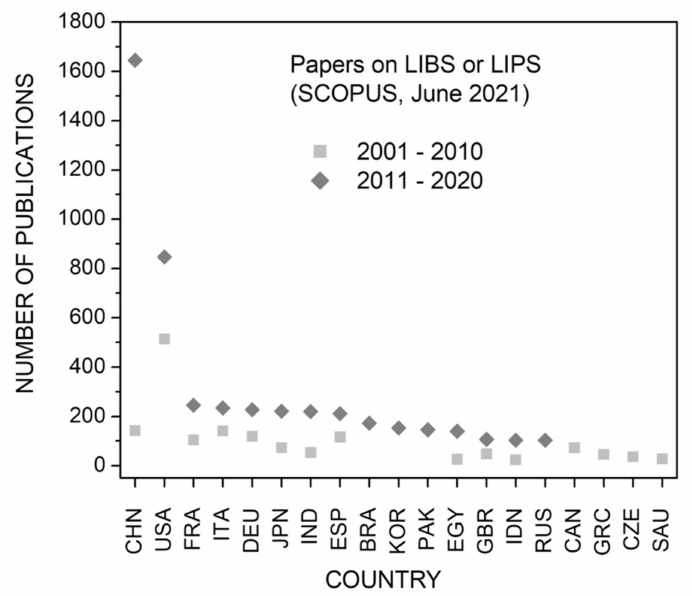
Figure A2. Fifteen top countries, i.e., most frequent country affiliations, regarding scientific papers on LIBS or LIPS published in years 2001–2010 and 2011–2020 (SCOPUS, June 2021) [484].